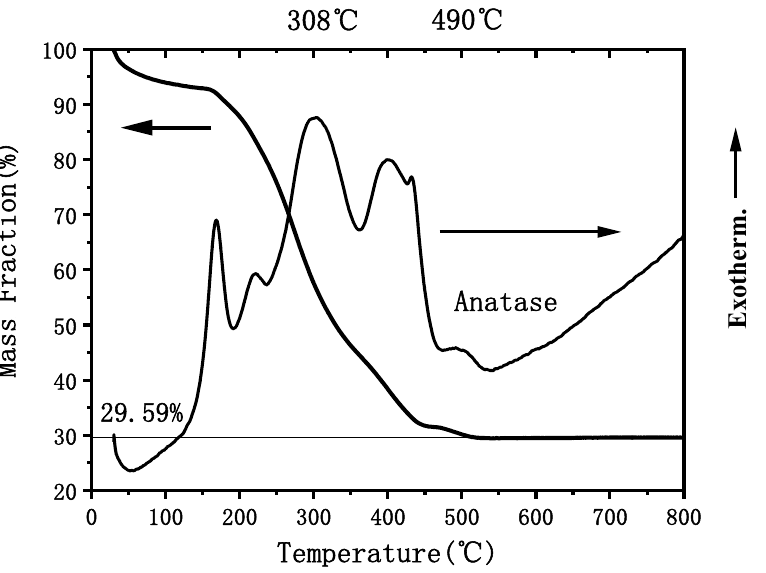
Figure 6. Differential heat-thermogravimetry curve of the sample scraped from the TiO 2 gel thin film.